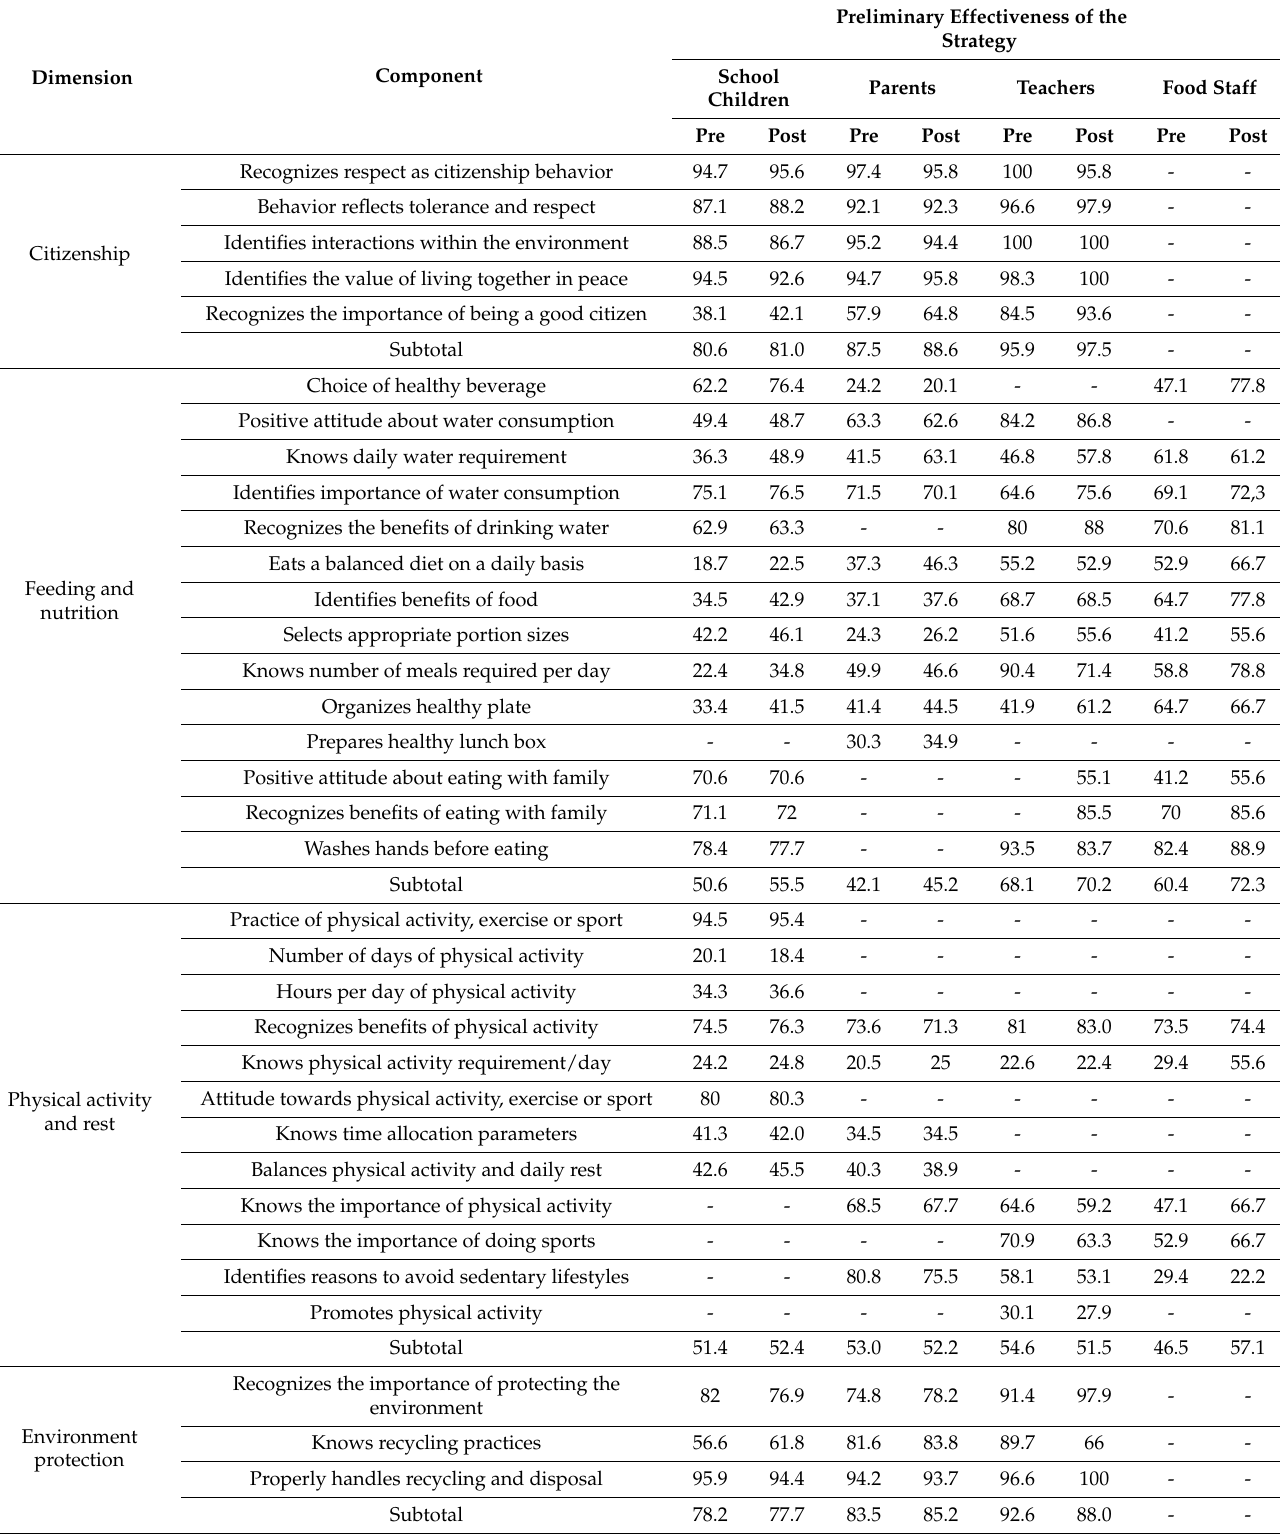
Table 2. Preliminary effectiveness results of the health promotion strategy “Prosalud” with the school community in the Andean region of Colombia,